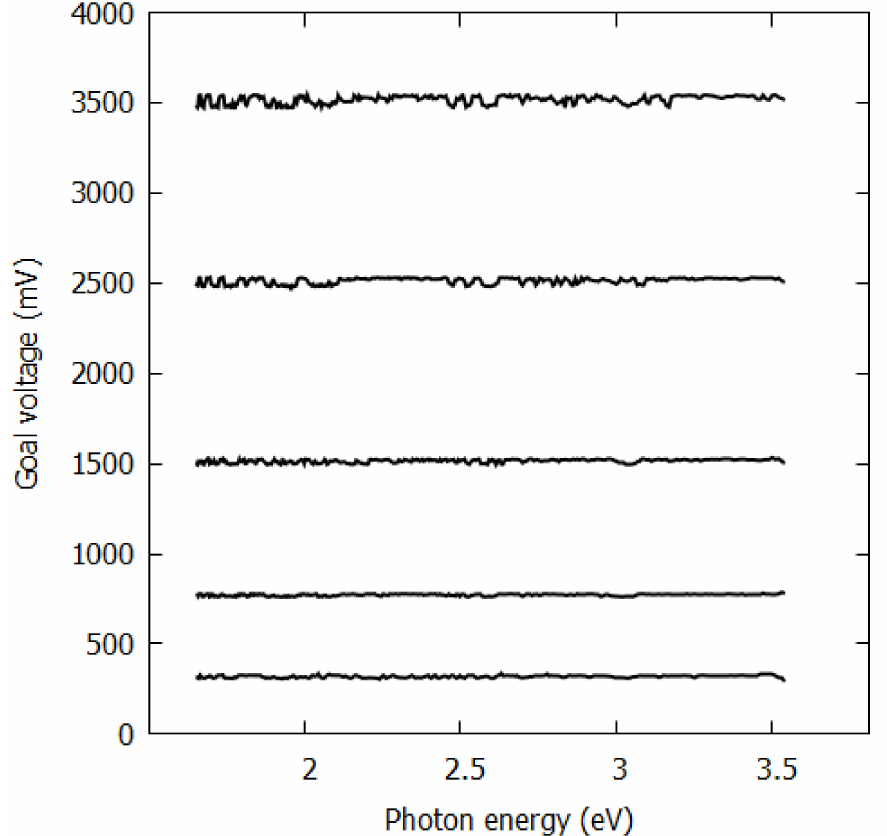
Figure 5. The result of the actual machine test. VNDF-controlled results of the DC component intensity ( V dc ) are shown as a function of the energy of the probe beam. The system can be adapted for a sufficiently wide range of V dc from 300 to 3500